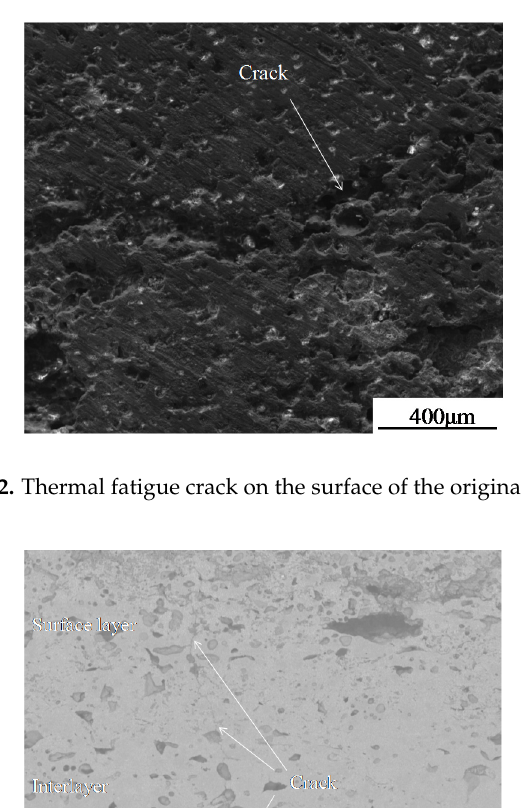
Figure 13. Micrograph of the cross ‐ section of the original coating after 600 thermal fatigue cycles.